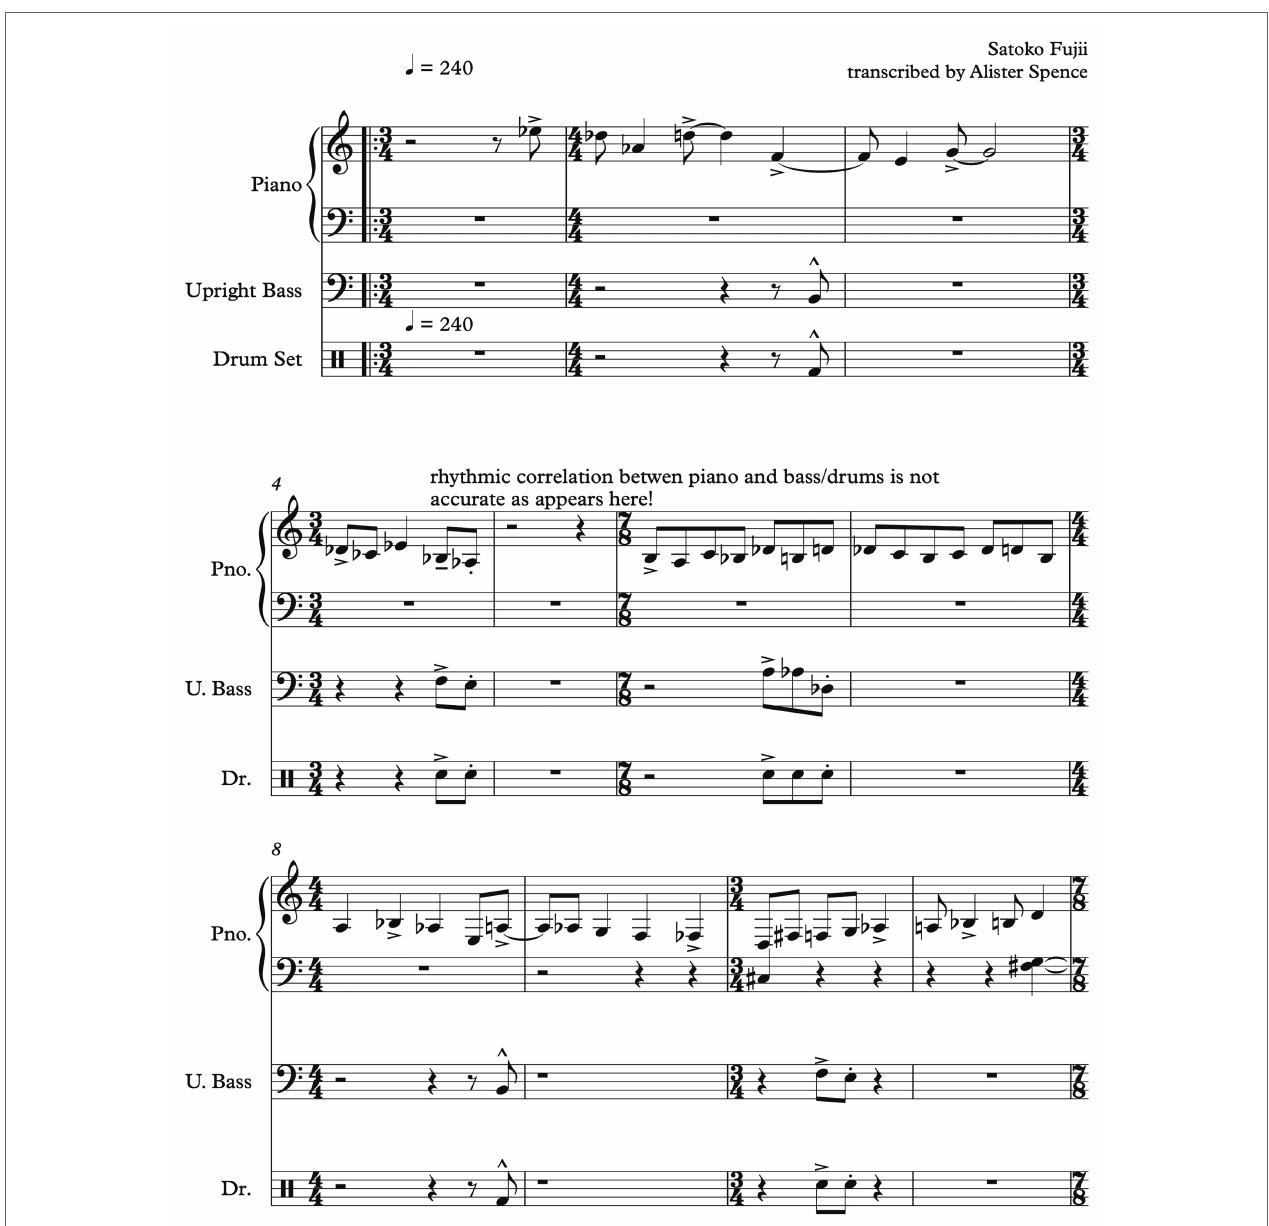
FIGURE 4 | “Spiral Staircase” piano improvisation and accompaniment excerpt (full